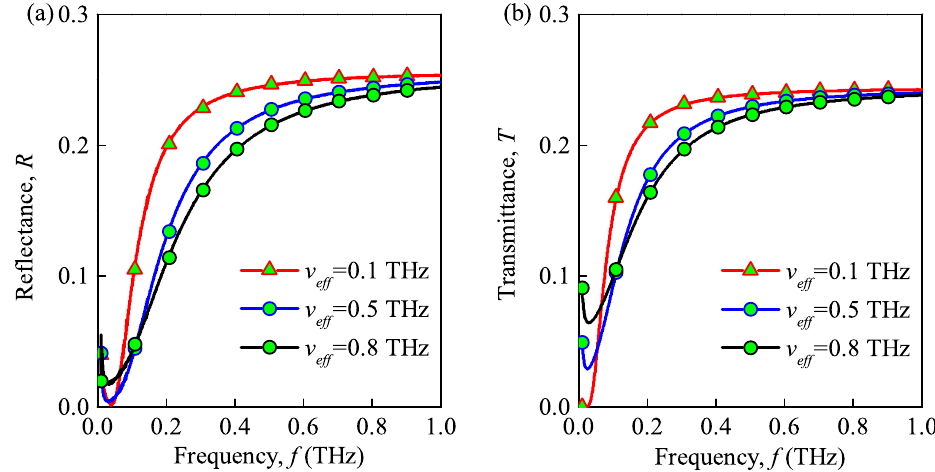
Figure 8. Reflectance ( a ) and transmittance versus ( b ) wave frequency under different collision frequencies. ( N 0 = 1 × 10 19 m − 3 , N d = 1 × 10 14 m − 3 , r d = 1 × 10 − 6